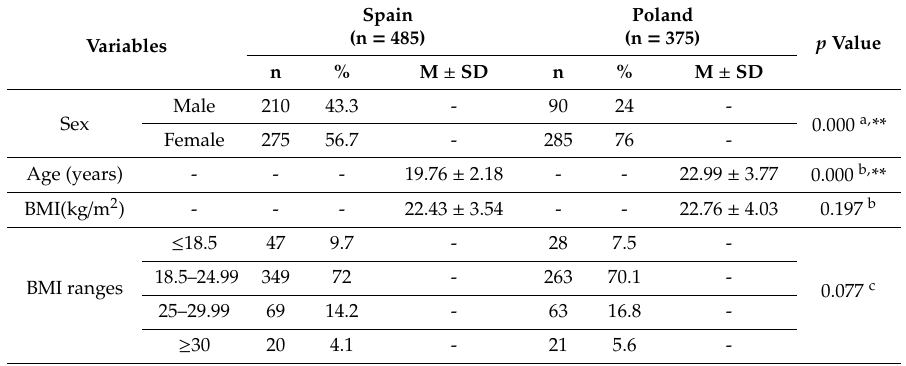
Table 2. Sociodemographic and anthropometric results in Spanish and Polish